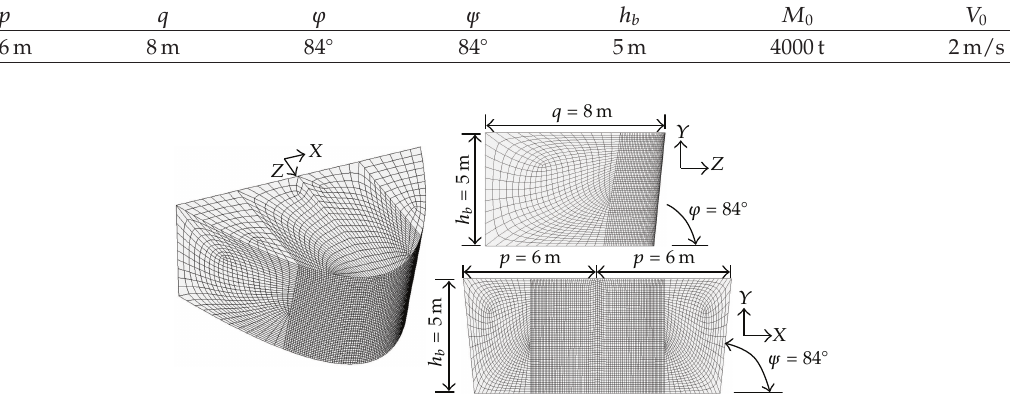
Figure 28: Numerical model of the striking vessel. Table 2: Useful properties for defining a rigid material law (cid:6) only required for contact simulation (cid:7) .